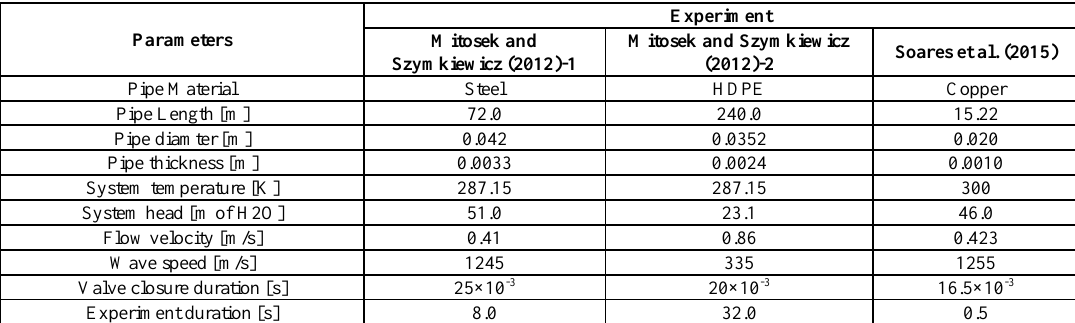
Table 1. Details of